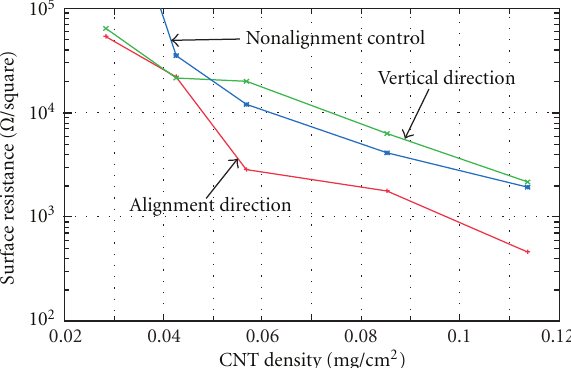
Figure 6: Surface resistance of CNT-composite paper (alignment direction, vertical direction, and nonalignment control).